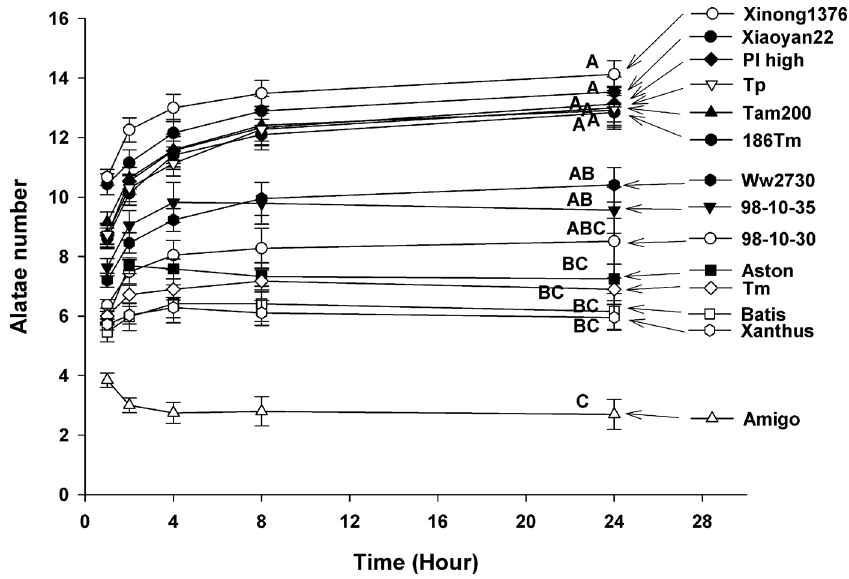
doi:10.1371/journal.pone.0156158.g002